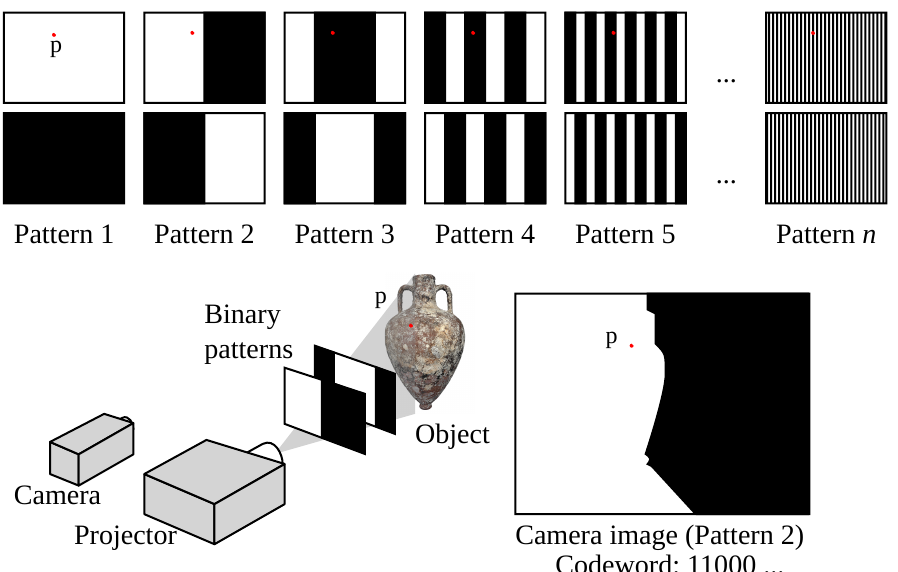
Figure 7. Binary structured light patterns. The codeword of a point p is created by the successive projection of